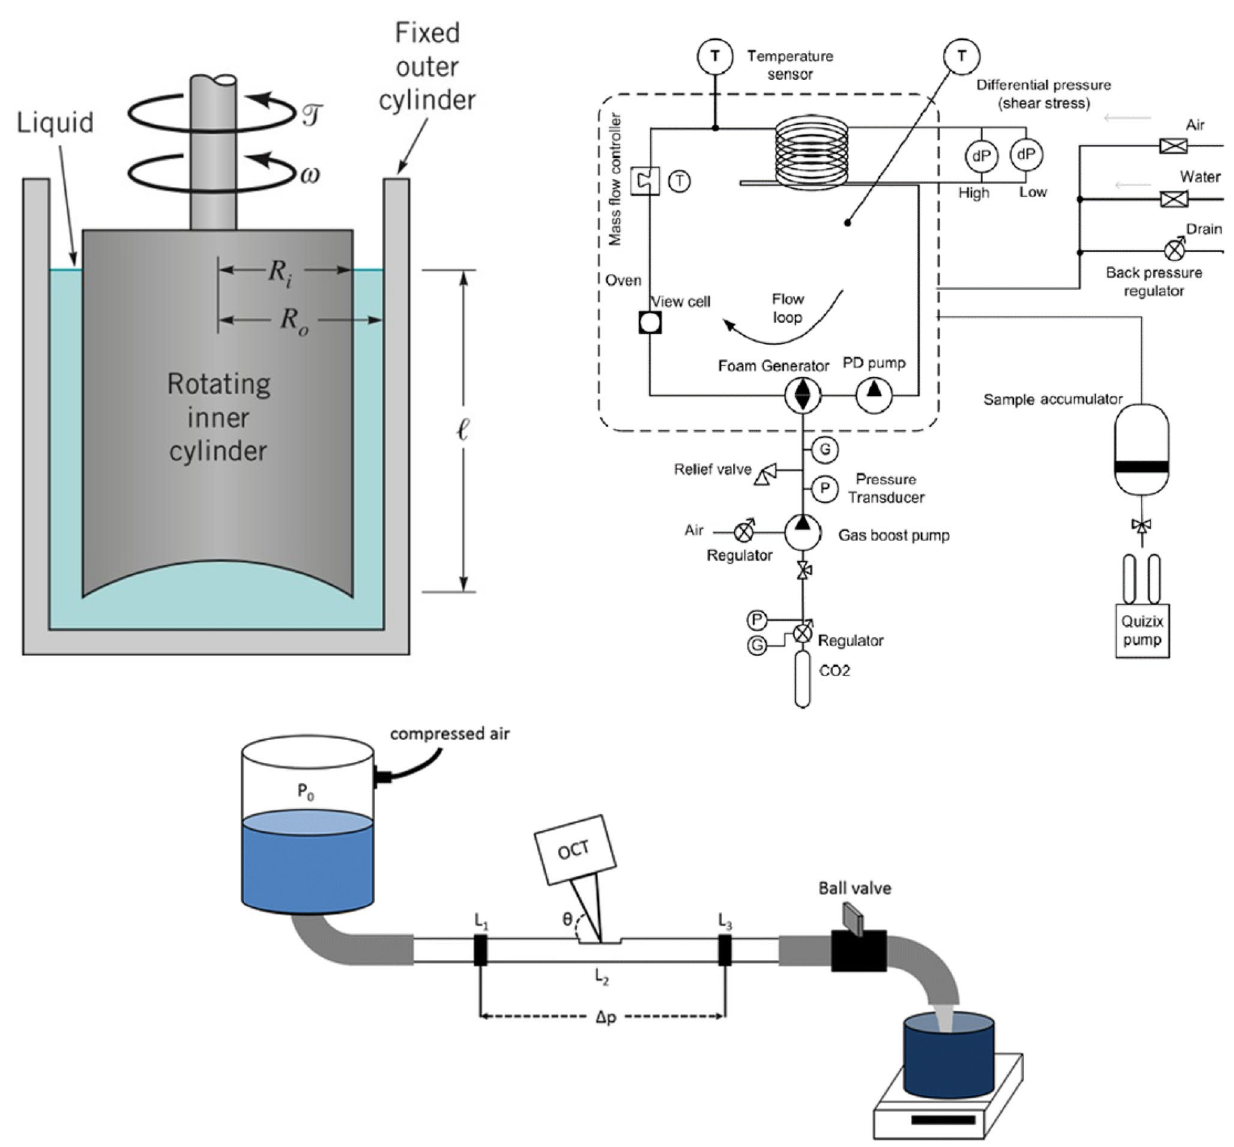
Fig. 8 Rotational, recirculating, and single-pass viscometers. (Hutchins and Miller 2005)